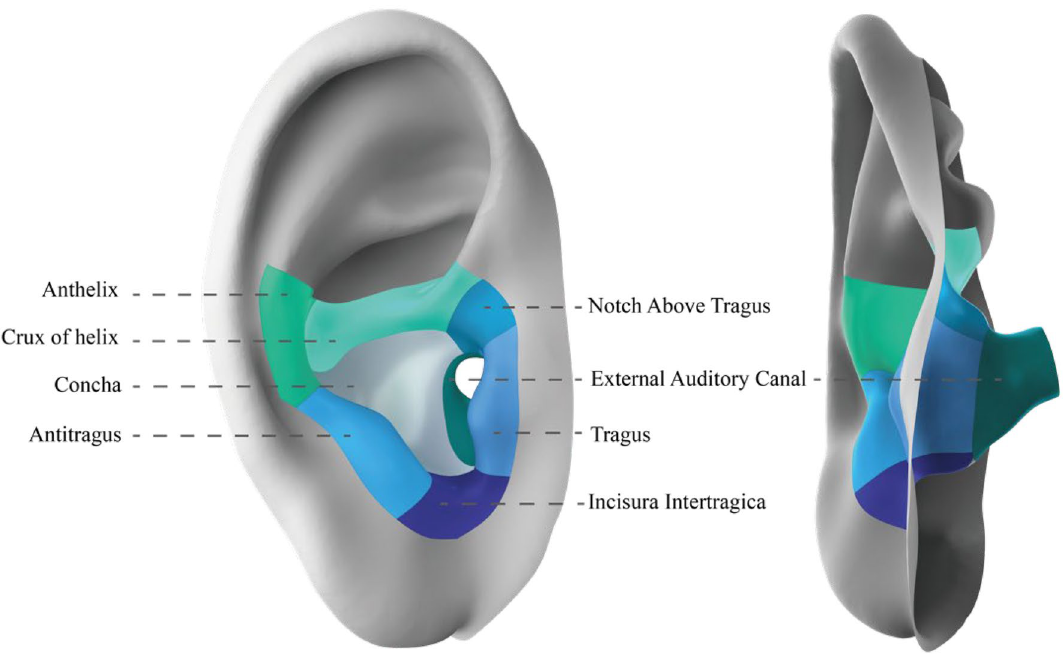
Figure 6. Eight anatomical ear